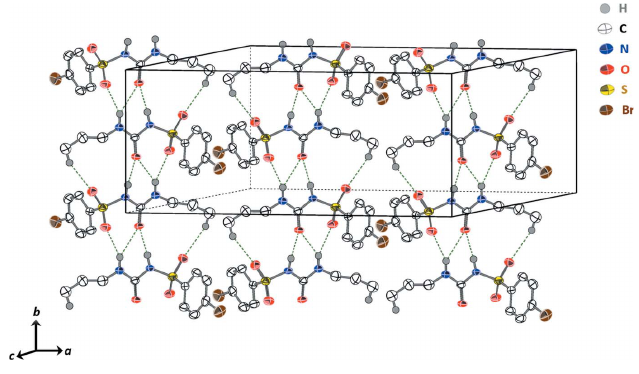
Figure 2 Infinite hydrogen-bonding involving the sulfonyl urea moiety in 4-bromo- N -(propylcarbamoyl)benzenesulfonamide. Hydrogen bonding between N1—H1 (cid:2)(cid:2)(cid:2) O2, N2—H2 (cid:2)(cid:2)(cid:2) O2, N2—H2 (cid:2)(cid:2)(cid:2) O3, and C10—H10 C (cid:2)(cid:2)(cid:2) O1 is shown as green dotted lines. Displacement ellipsoids are drawn at the 30% probability level. Only H atoms involved in hydrogen bonding are shown.